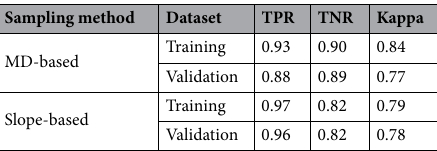
Table 2. Statistical measures of random forest model for different thresholds of Mahalanobis distance.